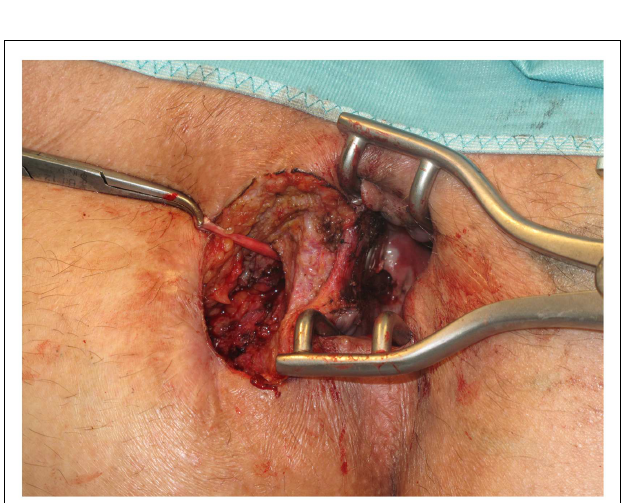
FIGURE 6 | For tight securing of the fixing button to the sphincter muscle, the plug is pulled by a forceps into the remaining intrasphincteric part of the complex anal fistula from outside